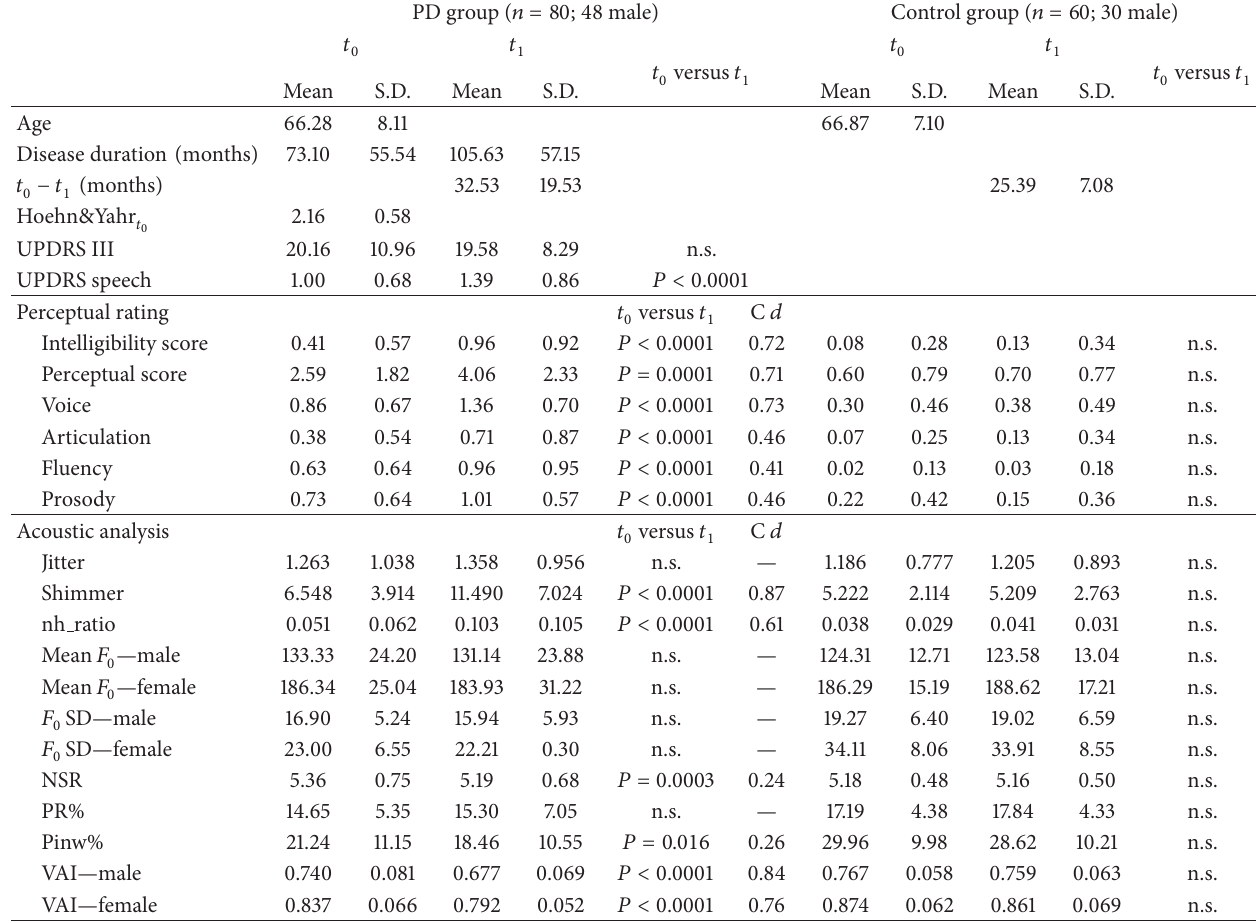
Table 1: Participants’ characteristics and